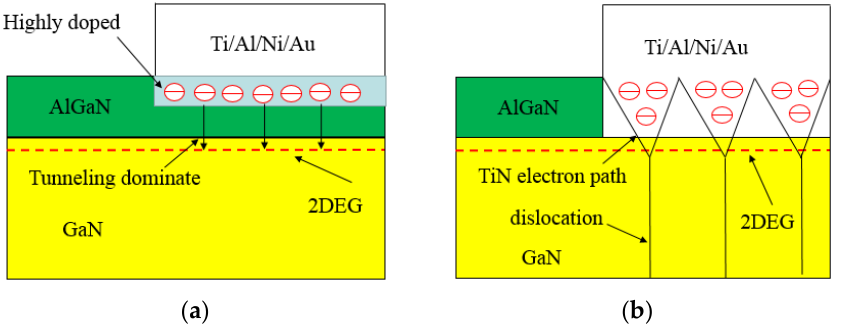
Figure 7. Physical models of Ti/Al/Ni(x)/Au ohmic contact to AlGaN/GaN HEMT: FE tunneling mechanism ( a ) and spike mechanism ( b ).